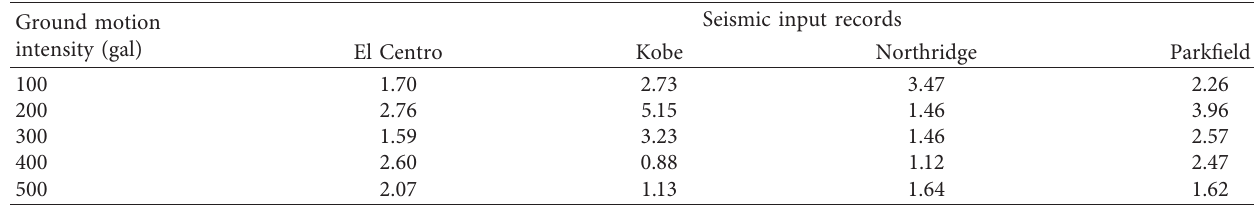
Figure 7: The normalized seismic input time histories. Table 1: Story-drift ratio errors